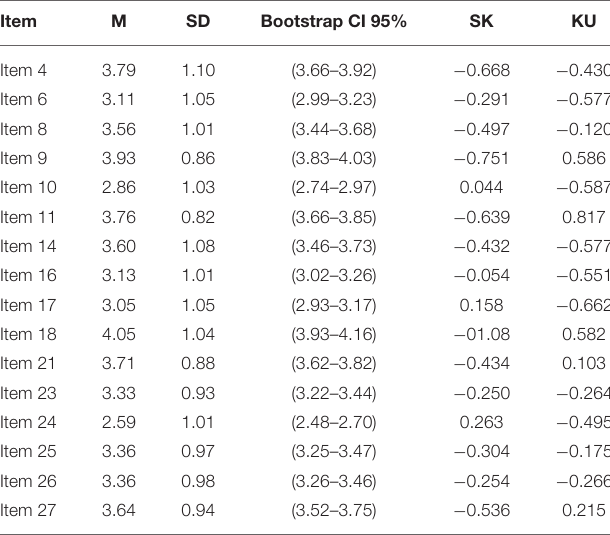
TABLE 1 | Descriptive statistics of the Interpersonal Reactivity Index (IRI) ( N =